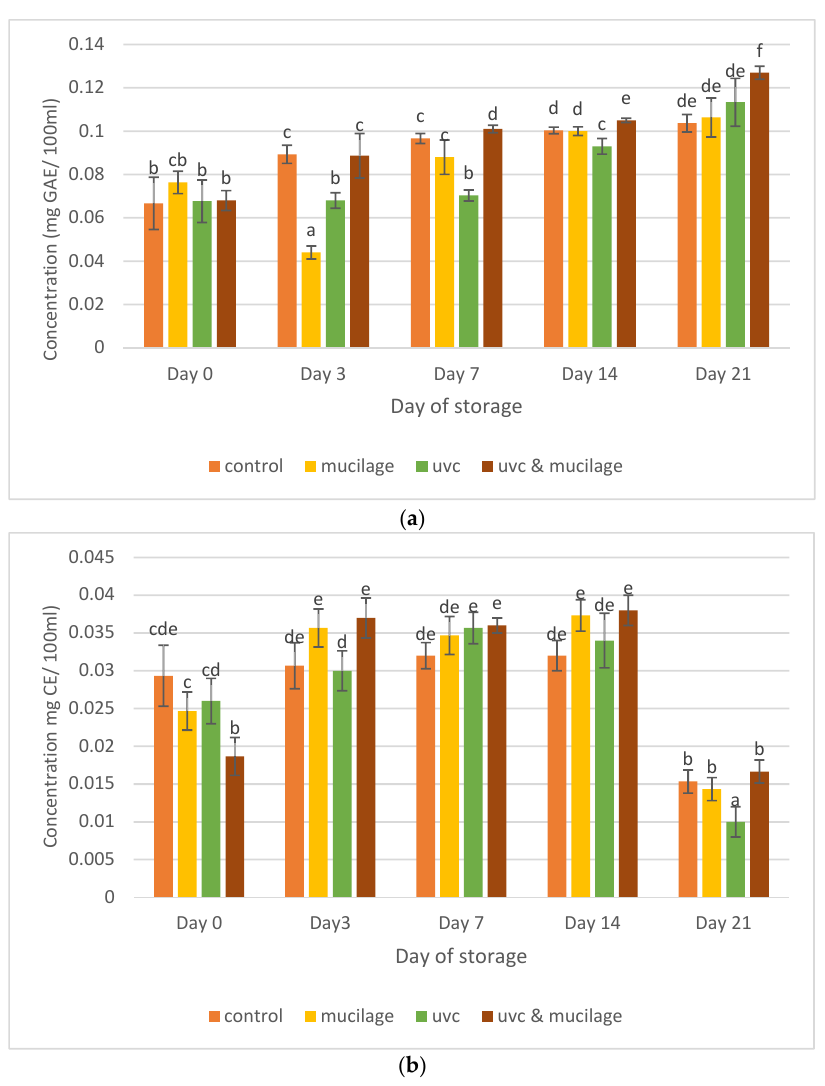
Figure 7. Effect of mucilage coating and UV-C on ( a ) total phenolic content and ( b ) total flavonoid content. Values followed by different letters within the same column are significantly different ( p < 0.05) ( n = 12).